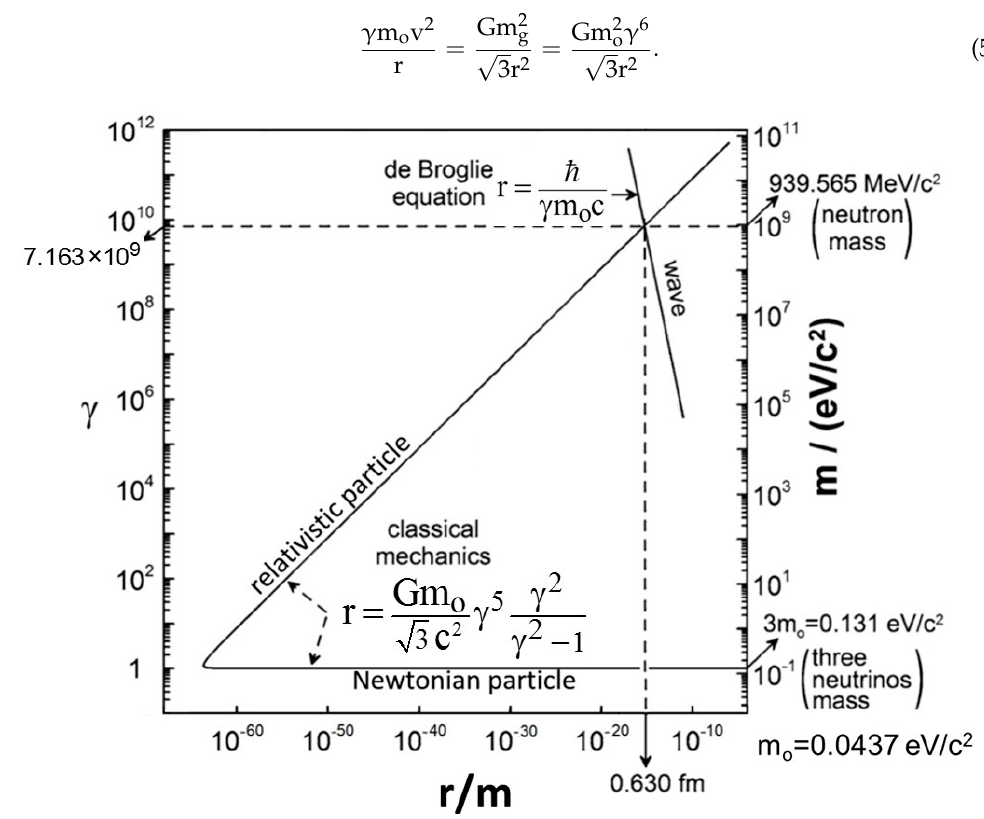
Figure 2. Plot of the relativistic equation for circular motion of three gravitating neutrinos each of rest mass m o (Equation (6)) and of the de Broglie equation for each of these particles (Equation (7)), which accounts for its dual wave–particle nature, showing that the intersection of these two curves defines the neutron mass (939.565 MeV/c 2 ) and radius (0.630 fm) in quantitative agreement with experiment [16]. The heaviest neutrino mass value used (m o = 0.0437 · eV/c 2 ) is computed from the equation m o = m 3/2 n /3 1/8 m 1/2 Pl derived from Equations (5) and (7), and it lies within the current experimental uncertainty limits of the heaviest neutrino mass measured at the Super-Kamiokande [14,15]. The neutron mass (939.565 MeV/c 2 ) is a factor of γ (=7.163 × 10 9 ) larger than the rest mass of the three neutrinos (0.131 eV/c 2 ) according to Equation (9).